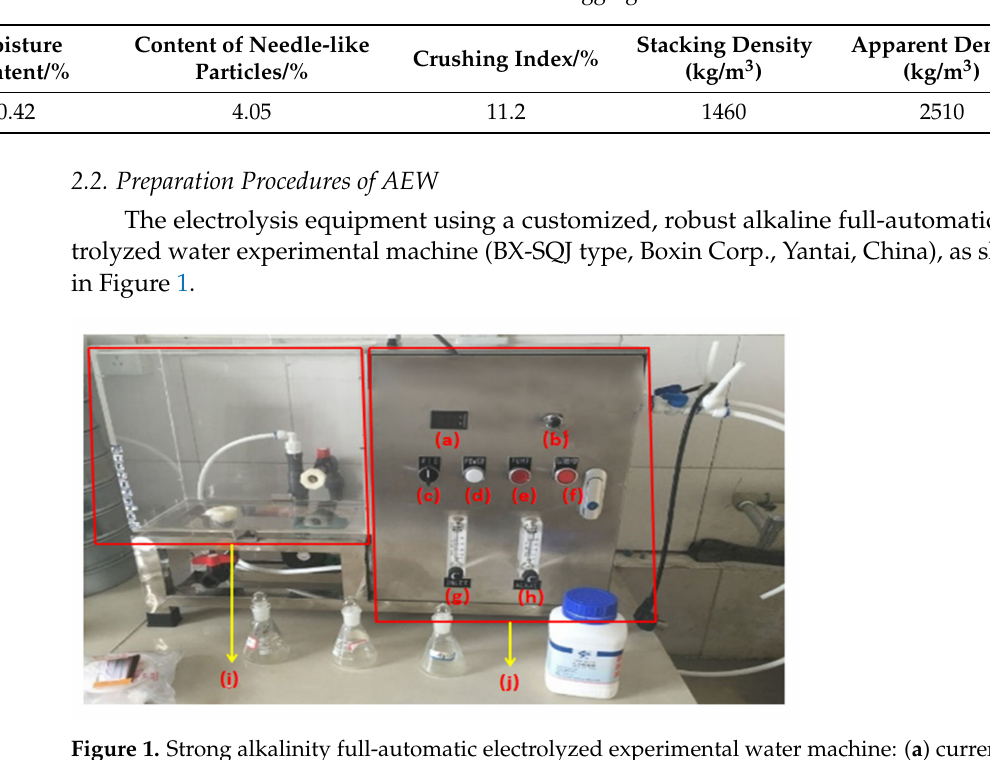
Figure 1. Strong alkalinity full-automatic electrolyzed experimental water machine: ( a ) current and voltage display screen; ( b ) current and voltage adjustment button; ( c ) total power supply; ( d ) power indicator lamp; ( e ) water pump power supply; ( f ) electrolytic power supply; ( g ) total water output adjustment button; ( h ) adjustment button for water output of AEW; ( i ) container; ( j )